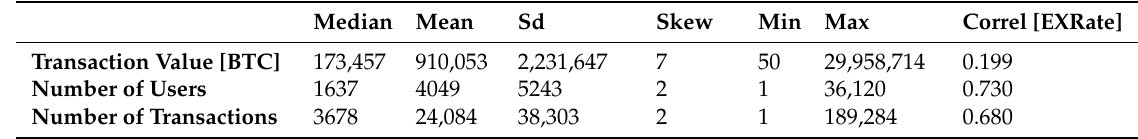
Table 1. Descriptive Statistics of the Bitcoin Network (on daily